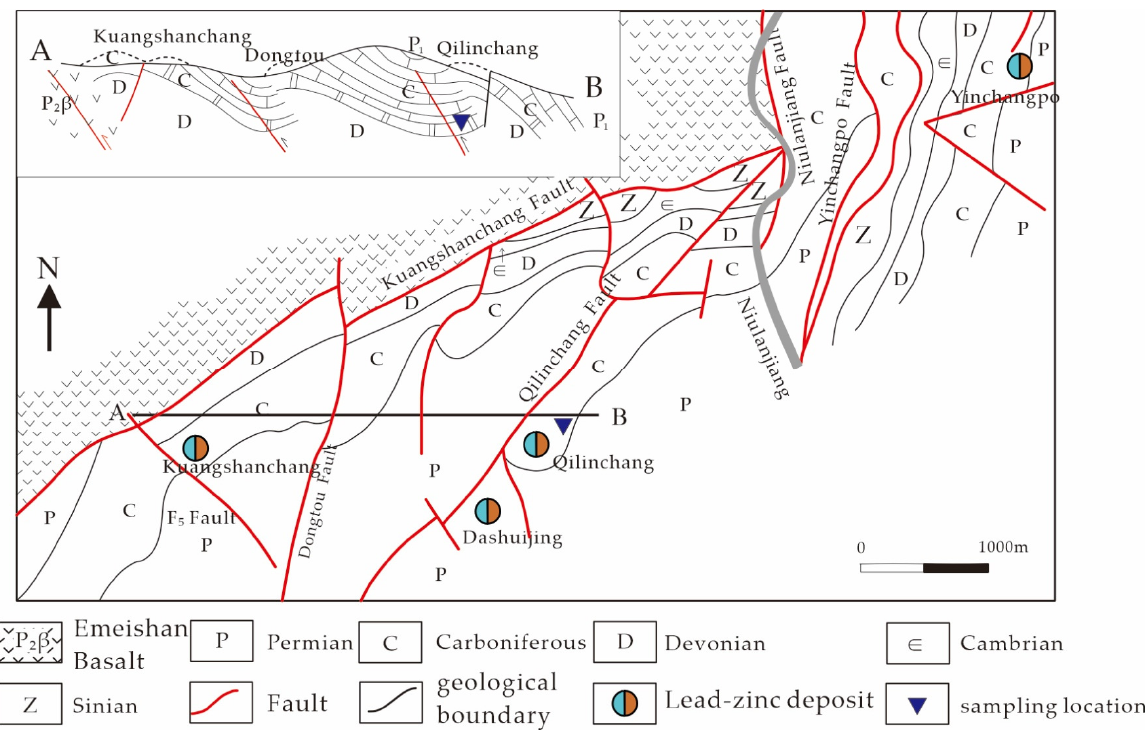
Figure 3. Geological map of the Huize lead–zinc deposit (modified from [29]). A, B: a geological section, including the mining area location, geological information and sampling location.